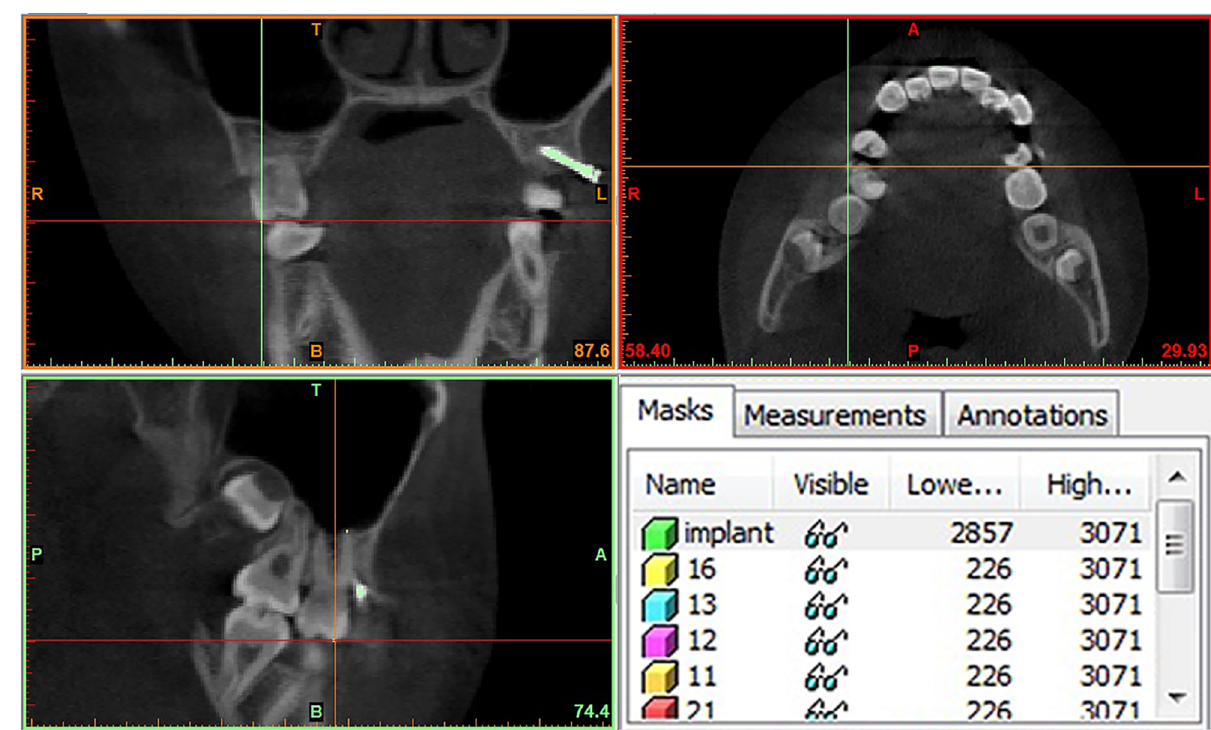
Fig 3. Segmentation of the metallic implants and tooth landmarks. Segmentation of the metallic implants from the maxilla and marking of tooth landmarks in the sagittal, coronal, and transverse planes. Separated masks of each tooth were created individually.